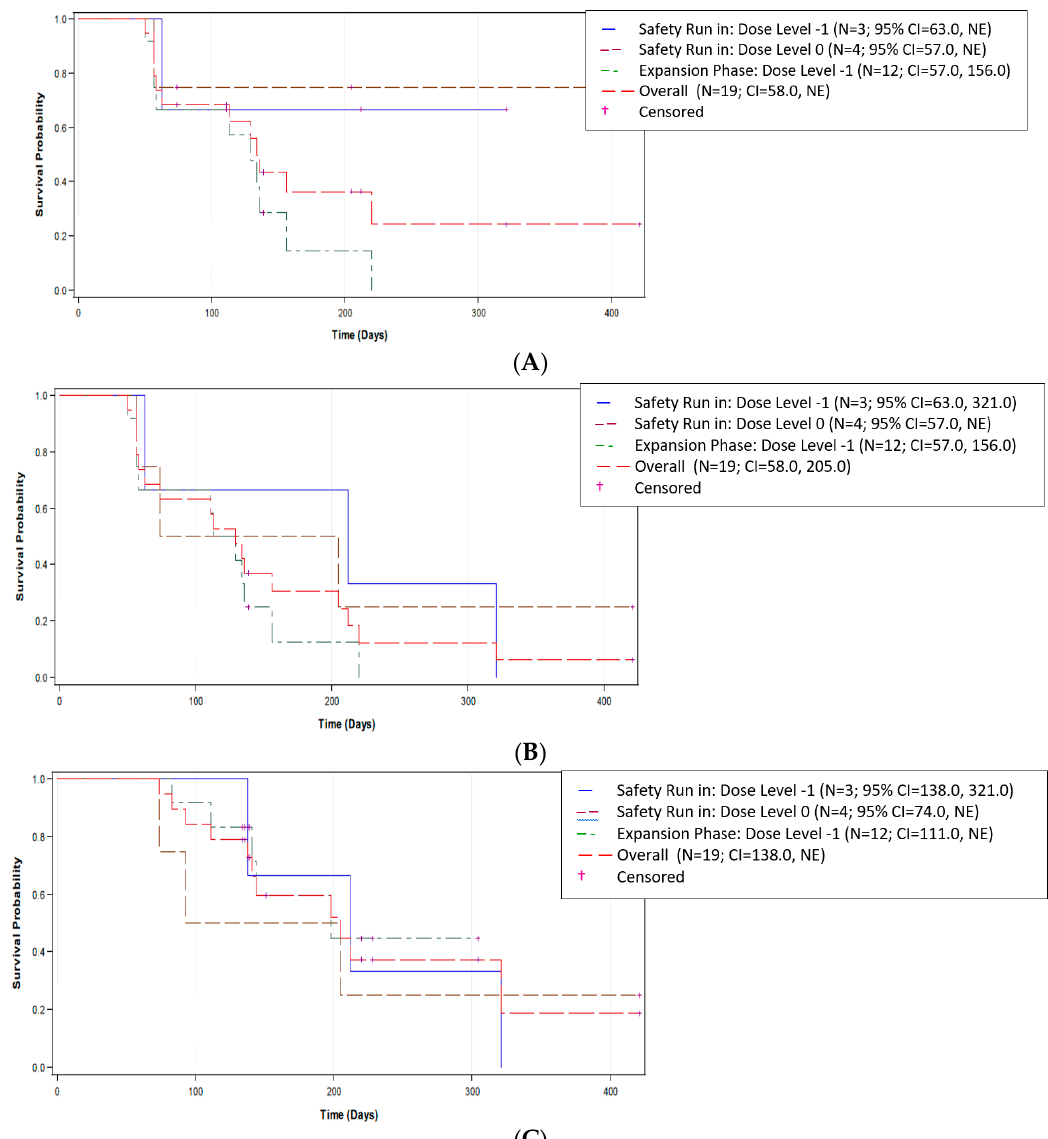
Figure 1. Plot of Kaplan–Meier estimates in the EE population for ( A ) time to disease progression (TTP), ( B ) progression-free survival (PFS), and ( C ) overall survival (OS). TTP was defined as the duration of time from the first dose of mipsagargin to the time of radiologic progression. The progression-free survival (PFS) and overall survival (OS) were estimated using Kaplan–Meier product limit estimates. PFS was defined as the duration of time from the date of the first dose of mipsagargin to the date of radiologic progression or death, whichever occurred first. OS is defined as the duration of time from the date of first dose of mipsagargin to the date of death from any